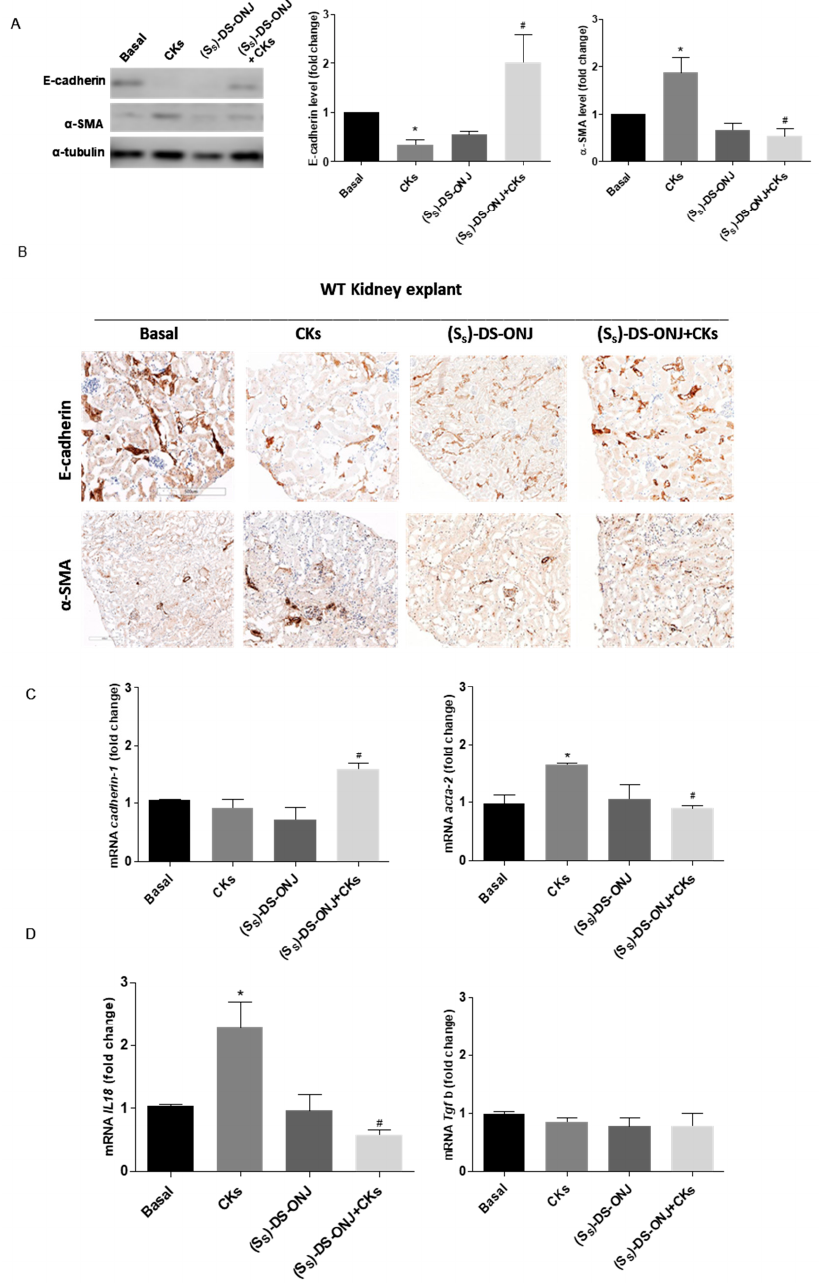
Figure 6. ( S S )-DS-ONJ reverts the EMT induced in CKs-stimulated AK explants from WT rats. ( A ) Protein extracts were analyzed by Western blot with antibodies against E-cadherin, α -SMA and α -